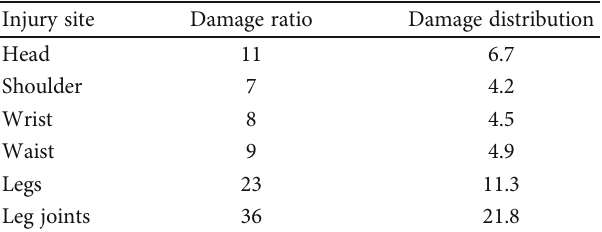
Table 2: Distribution of football injuries.